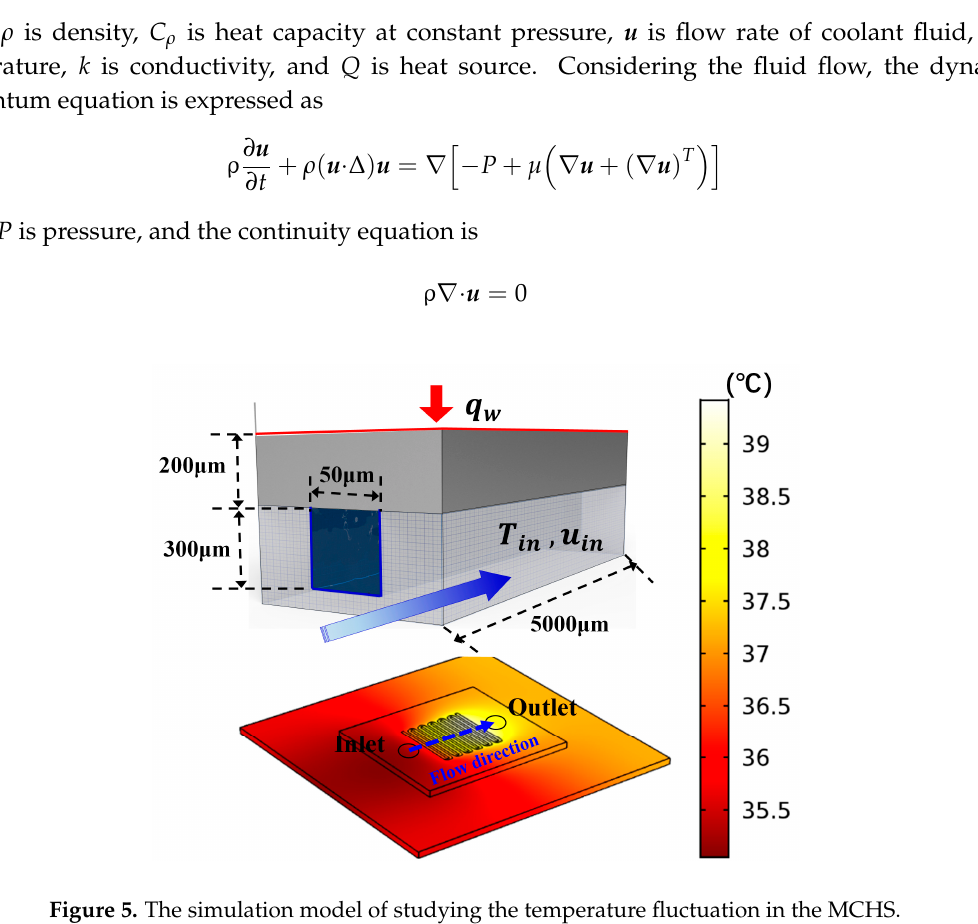
Figure 4. ( a ) Transient temperature responses at different locations for Case I (input power = 1.5 W)